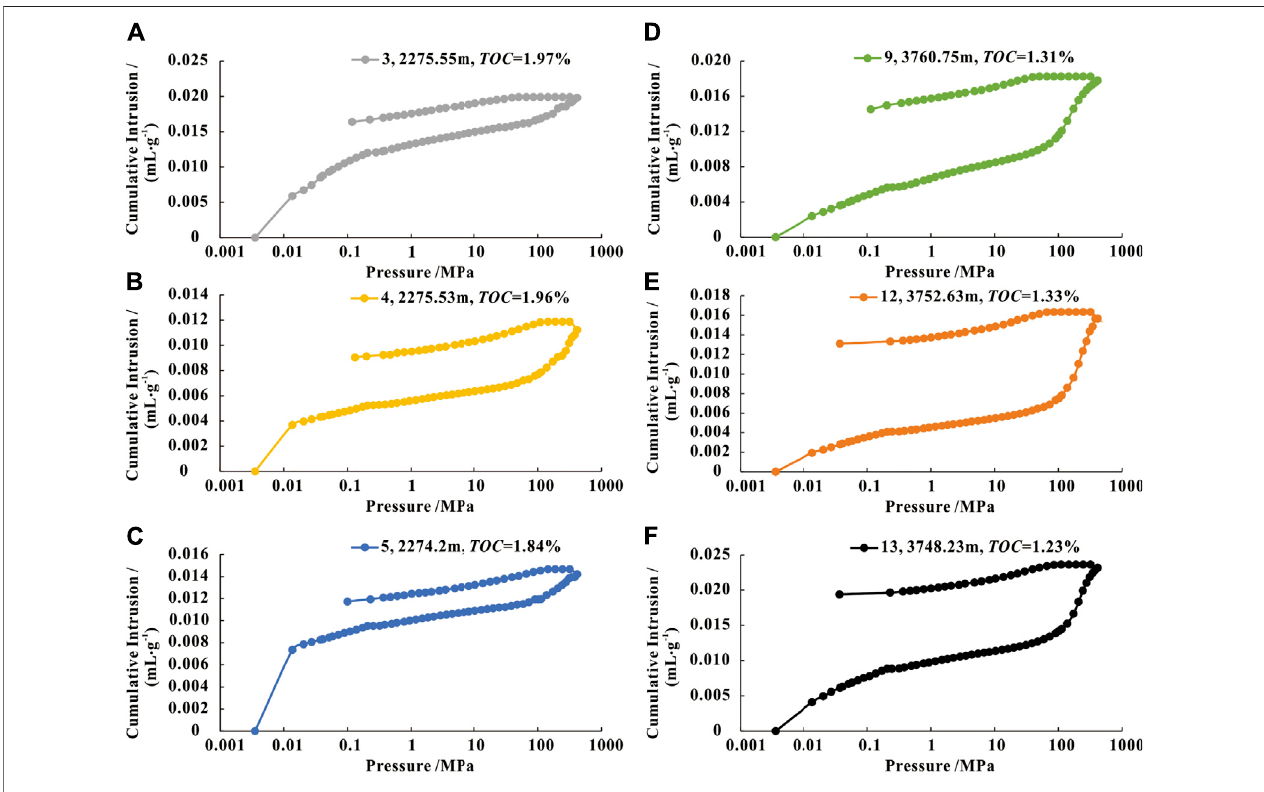
FIGURE5| MIPcurveofcontinental shale innortheasternSichuanBasin. (A) MIPresult oftheFuling areaofDongyuemiao Member sampleno. 3; (B) MIP resultof the Fuling area of Dongyuemiao Member sample no. 4; (C) MIP result of the Fuling area of Dongyuemiao Member sample no. 5; (D) MIP result of Yuanba area of Da ’ anzhai Member sampleno. 9; (E) MIPresult ofYuanbaareaofDa ’ anzhaiMembersampleno. 12; (F) MIPresult ofYuanbaareaofDa ’ anzhaiMember sampleno. 13.